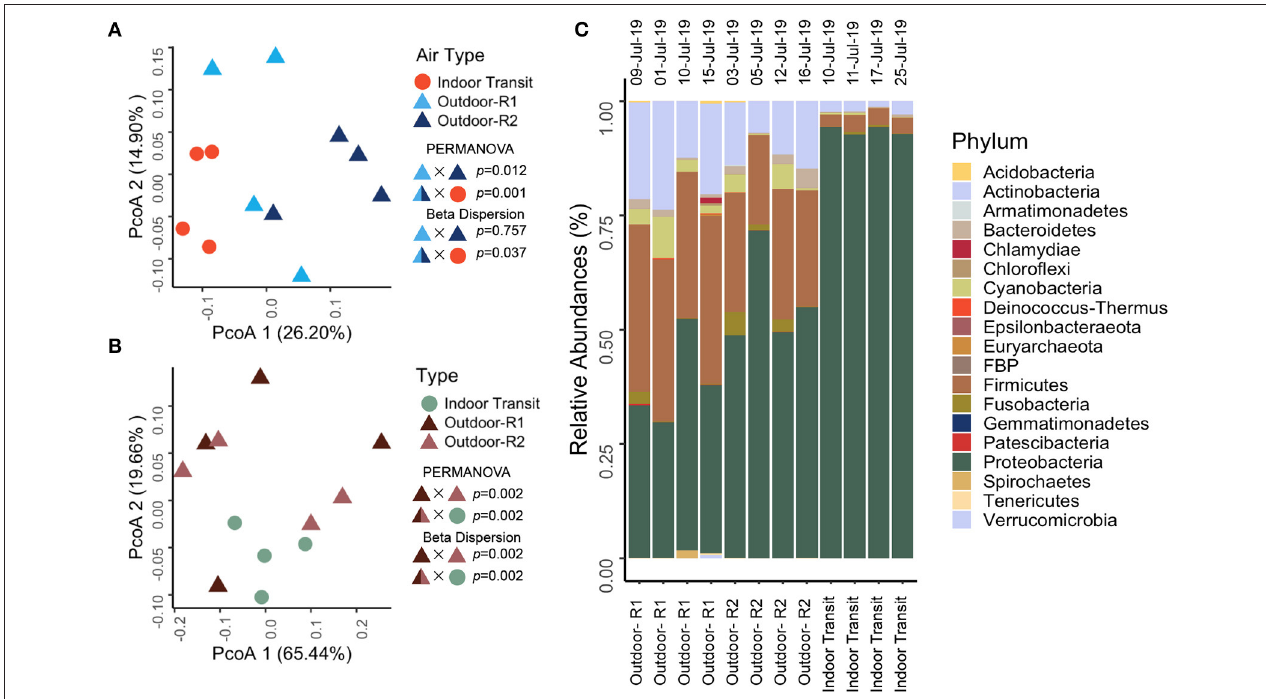
FIGURE 4 | (A) Principal Coordinates Analysis (PcoA) of phylogenetic beta-diversity (between sites) using unweighted UnifFrac distances with air type colored by site and shaped by indoor (circle) and outdoor (triangle) air. Shape/Color X Shape/Color indicates the factors used in hypothesis testing with the test above and p -value to the right. (B) Principal Coordinates Analysis (PcoA) of inferred functional potential beta-diversity (between sites) using Bray-Curtis dissimilarity with air type colored by site (green: indoor transit, dark brown: outdoor route 1, light brown: outdoor route 2) and shaped by indoor (circle) and outdoor (triangle) air. Shape/Color X Shape/Color indicates the factors used in hypothesis testing with the test above and p -value to the right. It should be noted the split color is for visualization and statistical tests were conducted on outdoor ∼ indoor samples. (C) Relative abundances of phyla identified in samples separated by air type (outdoor route 1 vs. outdoor route 2 vs. indoor transit) with collection date above each